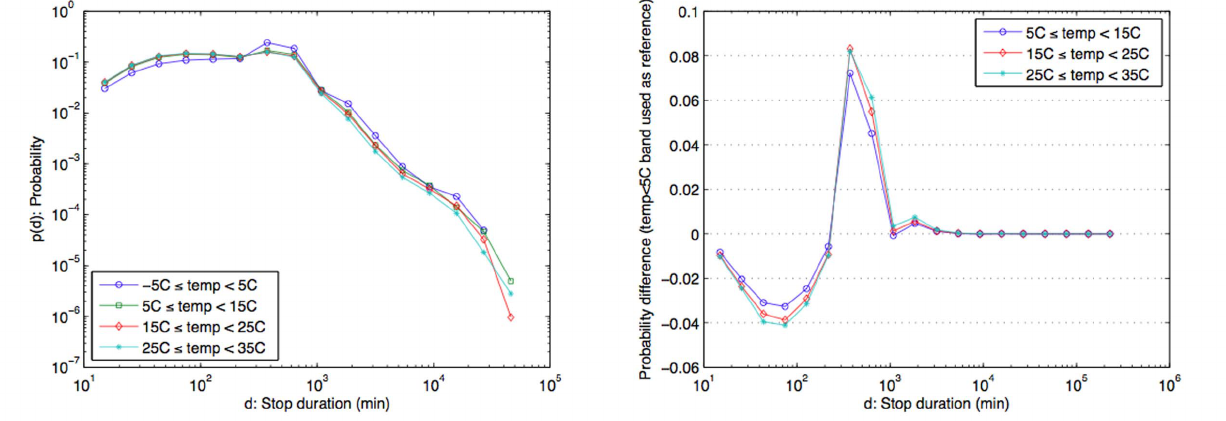
Figure 9. Probability mass function of stop duration under different bands of temperature and probability difference compared with the temperature band of less than 5 6 C.